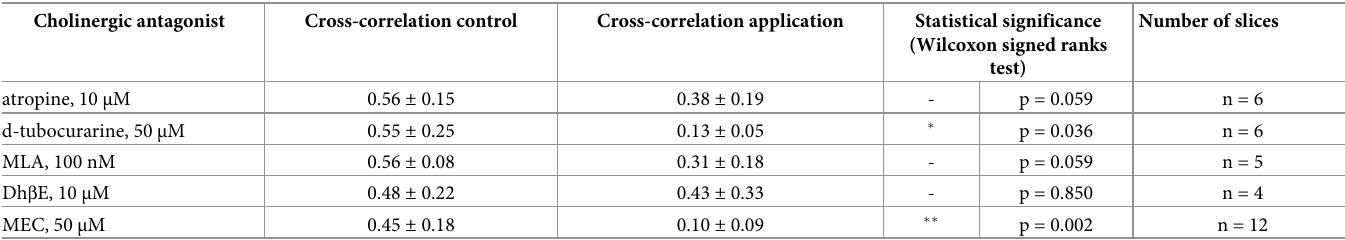
Table 1. Effect of cholinergic antagonists on CA3-CA1 synchronization of epileptiform discharges. Cholinergic antagonist